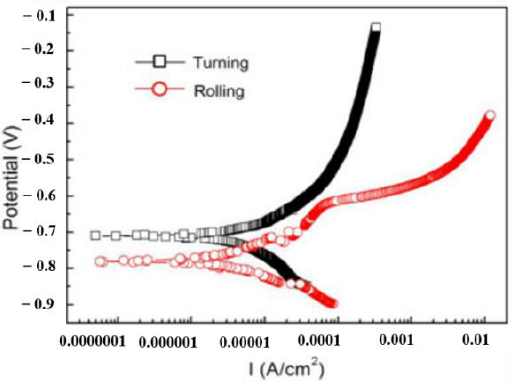
Figure 14. Polarization curve of turned and USRP treated uranium metal bar. Reprinted with per- mission from ref. [41]. Copyright 2021 Elsevier.